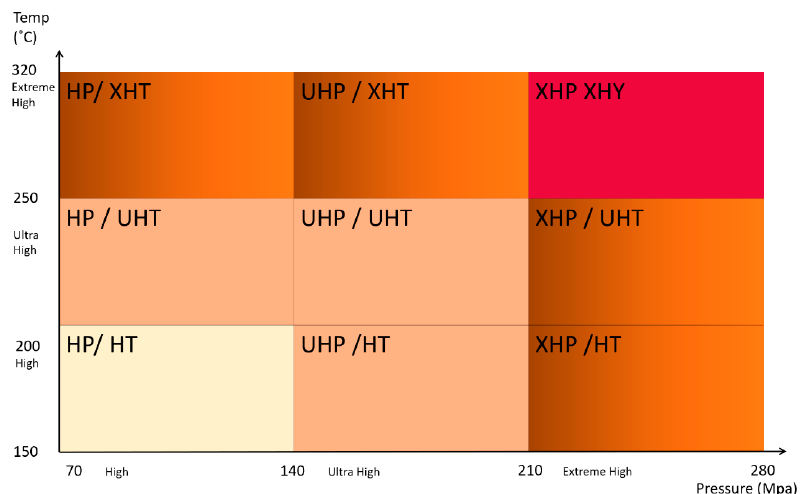
Figure 15. Matrix of HPHT operations representing the main operational tiers—high, ultra-high, and extreme high [5].